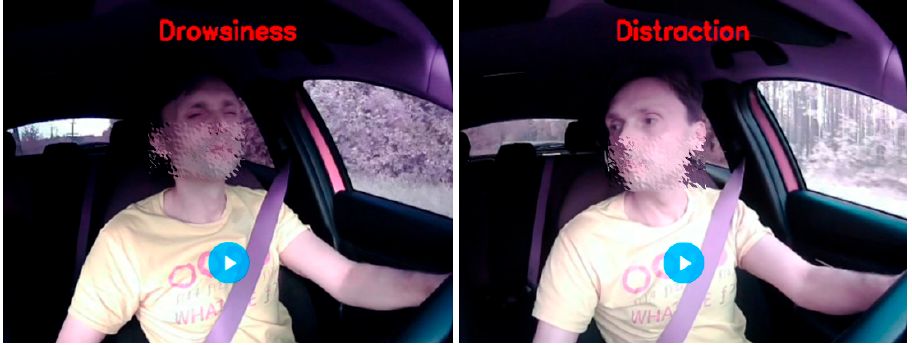
Figure 3. Drowsiness and distraction use cases.